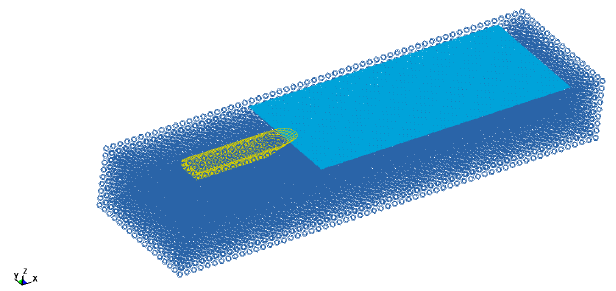
Figure 3. A typical configuration of the present numerical